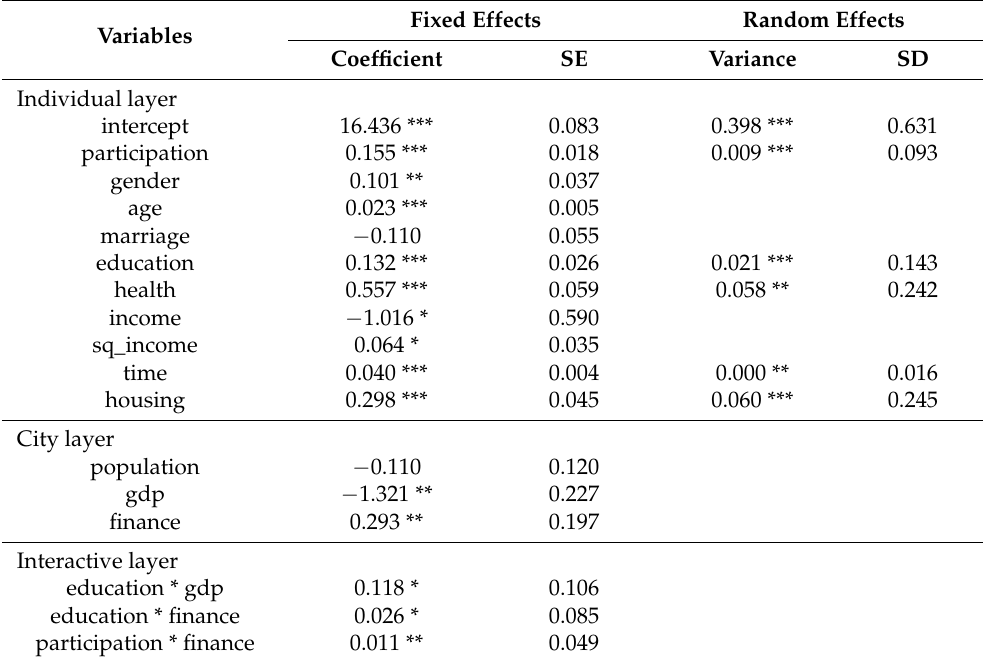
Table 6. Results of the mixed effects model on the influencing factors of the perceived social integra- tion new urban immigrants